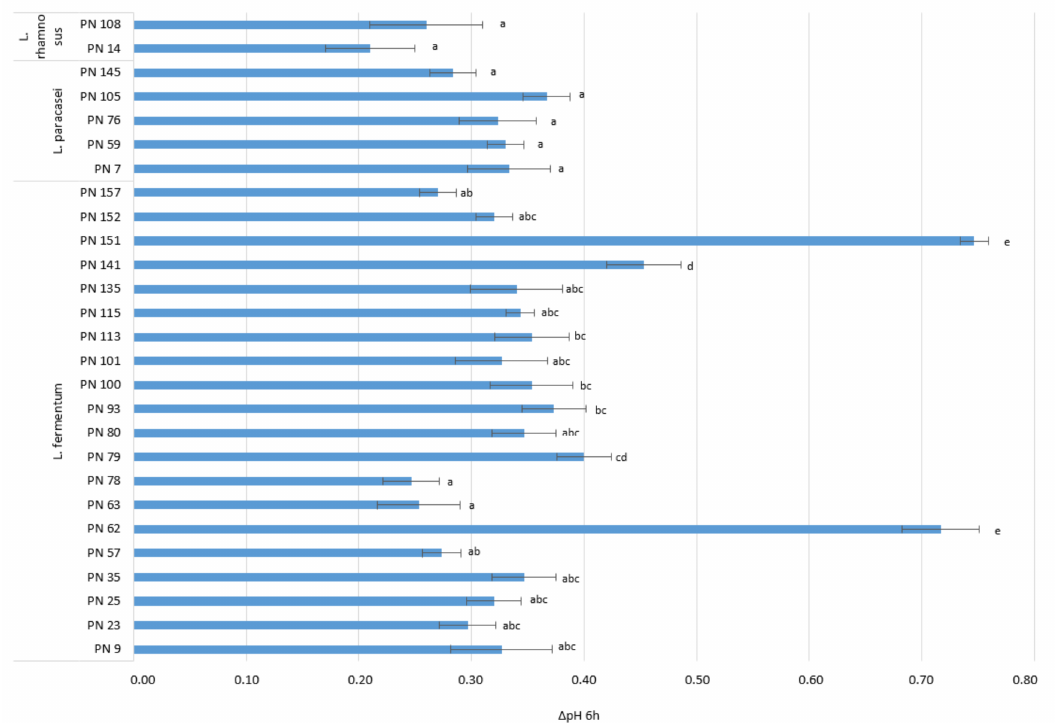
Figure 2. Acidification activity of the selected NSLAB strains isolated from artisanal semi-hard Provola dei Nebrodi PDO cheese samples. Results are reported as mean and standard deviation of three replicates. For each species, bars with different lowercase letters ( a – e ) are significantly different at p <